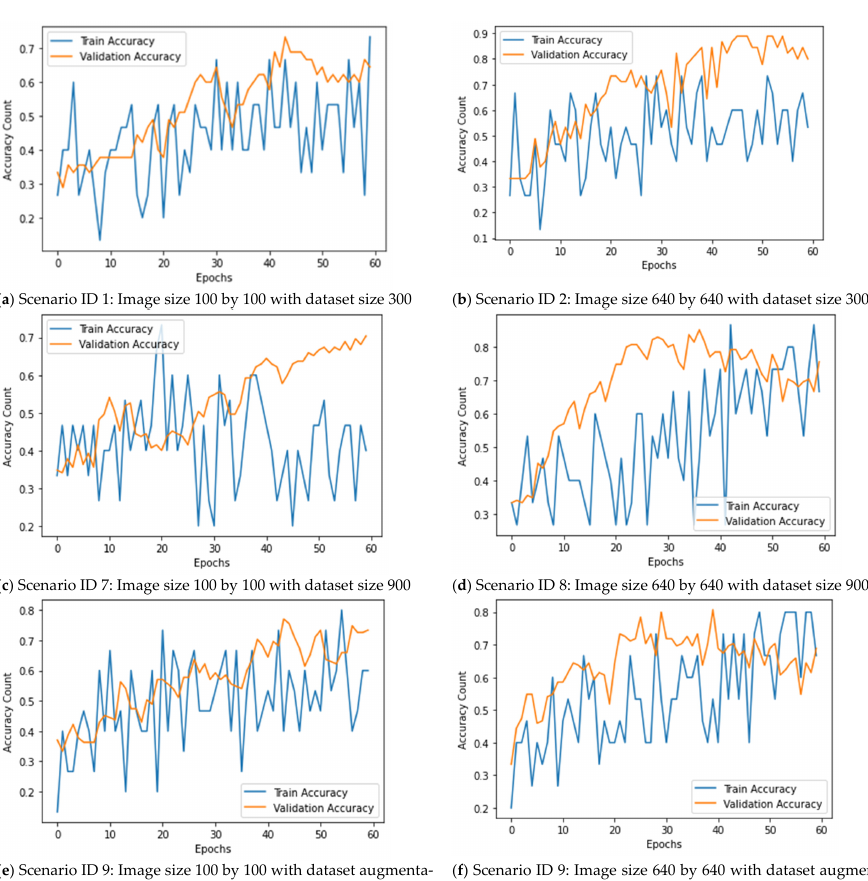
Figure 9. Accuracy plots of basic CNN.